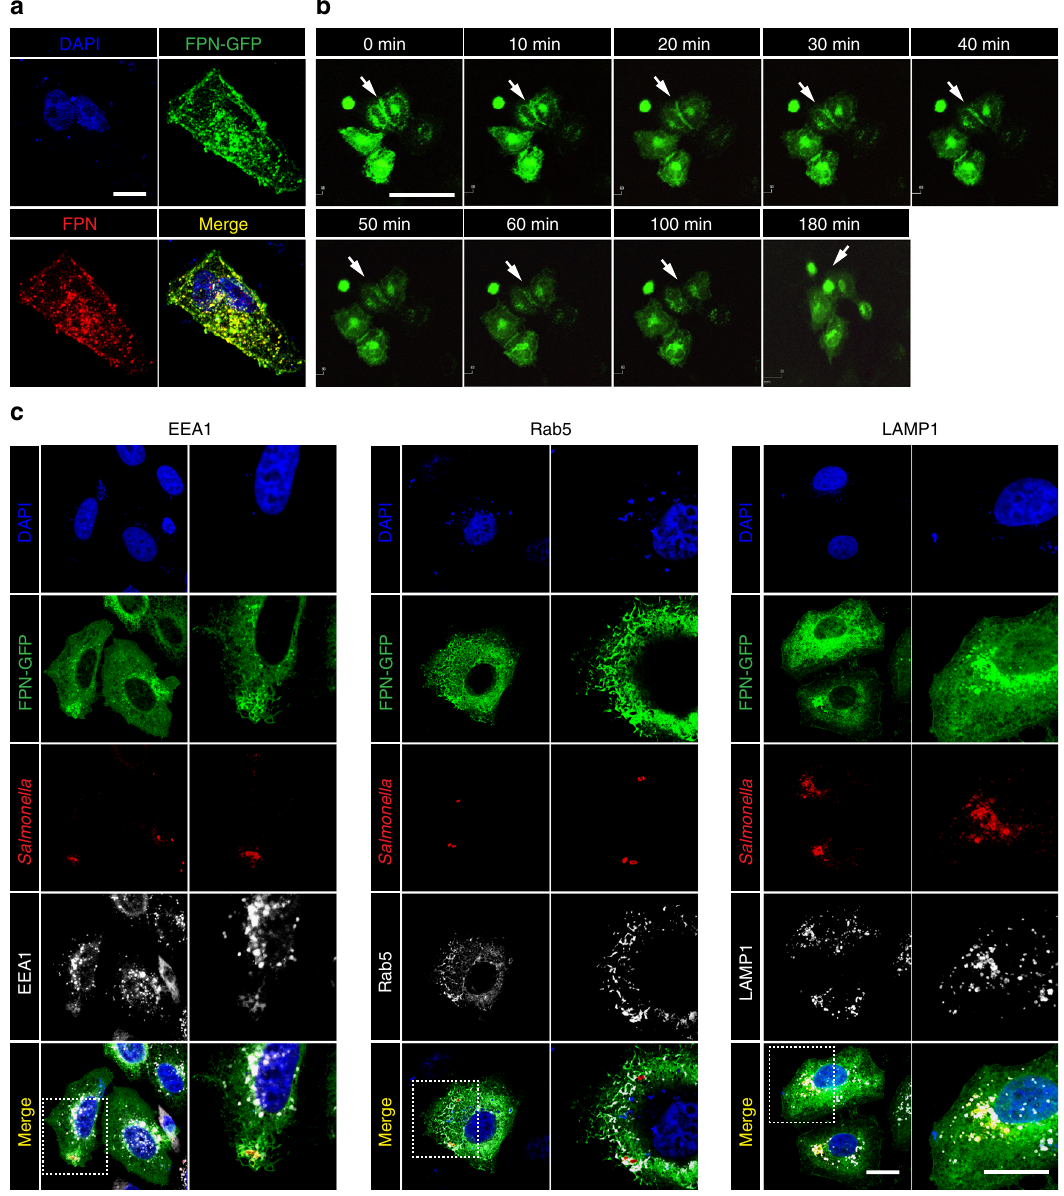
Fig. 2 Localization of FPN with respect to SCV-associated marker proteins. a HeLa cells transfected with pFPN-EGFP were stained with an anti-FPN antibody and visualized by confocal microscopy. Scale bar, 10 μ m. b Live cell images after treatment of HeLa cells expressing FPN-GFP with hepcidin. Arrows indicate FPN on the plasma membrane. Scale bar, 50 μ m. c HeLa cells expressing FPN-GFP were infected with Salmonella (MOI, 100) and stained for the markers of early and late SCV (EEA1 and Rab5 at 1 h p.i. and LAMP1 at 12 h p.i.). Scale bar 10 μ m. Images are representatives of over 100 infected cells from at least six independent experiments. The images on the left were taken at ×1000 magni fi cation and on the right at ×2000 magni fi cation, which were marked in dotted box on the left